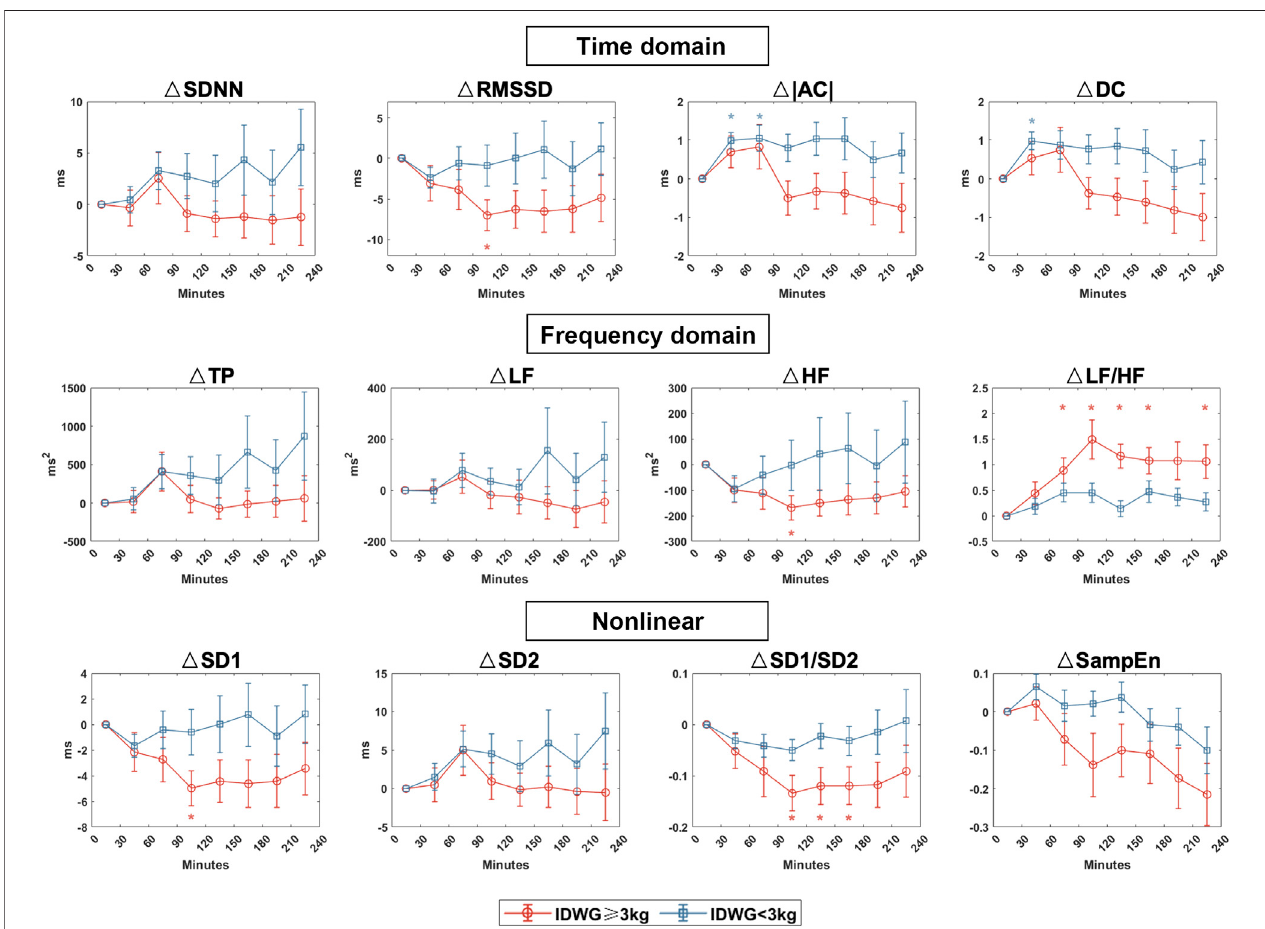
FIGURE5| HRVdynamicchangesinGroupA(IDWG ≥ 3 kg)andGroupB(IDWG < 3 kg).Changesinthetimedomain(SDNN,RMSSD,|AC|,DC),frequencydomain (TP, LF, HF, LF/HF),and nonlinear (SD1, SD2, SD1/SD2, SampEn) measurementof HRV compared with 0 – 30 min in two subgroups. Red and blue lines or “ * ” stand for IDWG ≥ 3 kg and IDWG < 3 kg, respectively. “ △ ” stands for the difference compared to the baseline. “ * ” stands for statistically signi fi cant ( p < 0.05) by one-way repeated measures ANOVA adjusted by Bonferroni ’ s multiple comparisons tests ( vs the baseline in 0 – 30 min). Error bars stand for the standard error of the mean (SEM).